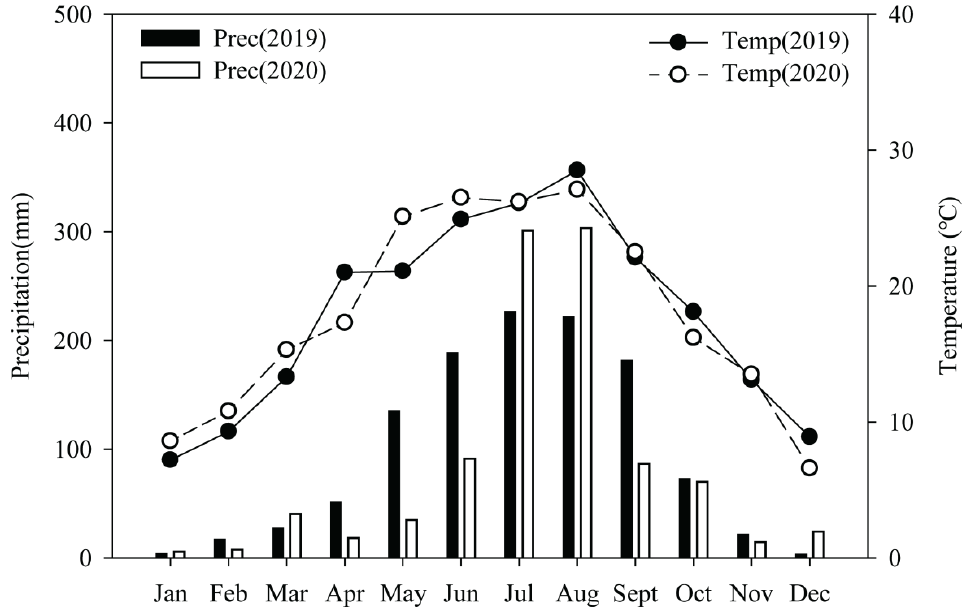
Figure 1. Temperature and precipitation of Zhongjiang County during the study period in 2019 and 2020. Note: Prec, Total monthly precipitation (mm); Temp, Average monthly temperature (°C).